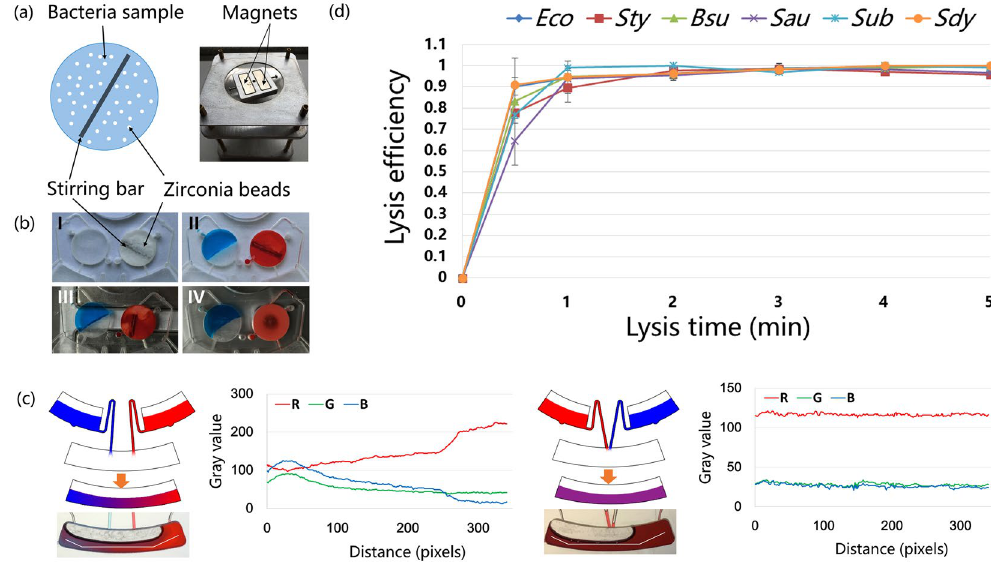
Figure 2. Illustration of lysis chamber, mixing chamber, and the optimal lysis time for six kinds of bacteria. ( a ) Illustration of the lysis chamber and the photo of the magnets equipped with a motor. ( b ) Photos of the lysis chamber, zirconia beads, and stirring bar. Picture I shows the filling of beads and bar, and then, sample (red dye) and mastermix (blue bye) were injected into the chip (II). Next, the chip was placed above the magnets (III), and a rotary motor was actuated (IV). ( c ) Two different configurations of the siphon channels. Radial siphon channels led to inhomogeneous mixing, but when the siphon channels were close to each other, uniform mixing was obtained. The white broken line in the mixing chamber displays the route of the RGB analysis. ( d ) Optimization of lysis time for different